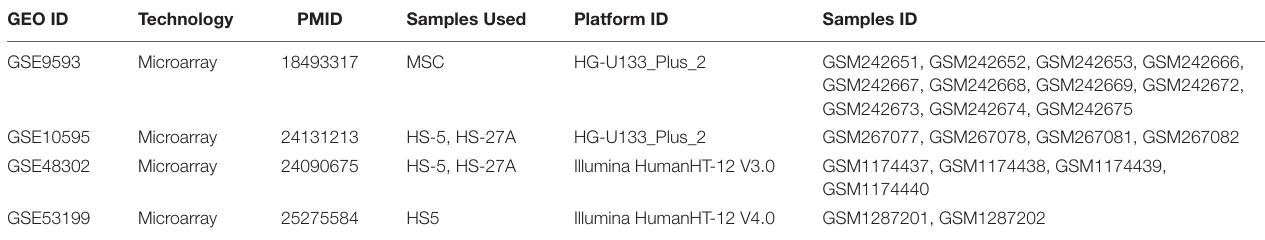
TABLE 1 | Details of the datasets and samples used for the expression profiles